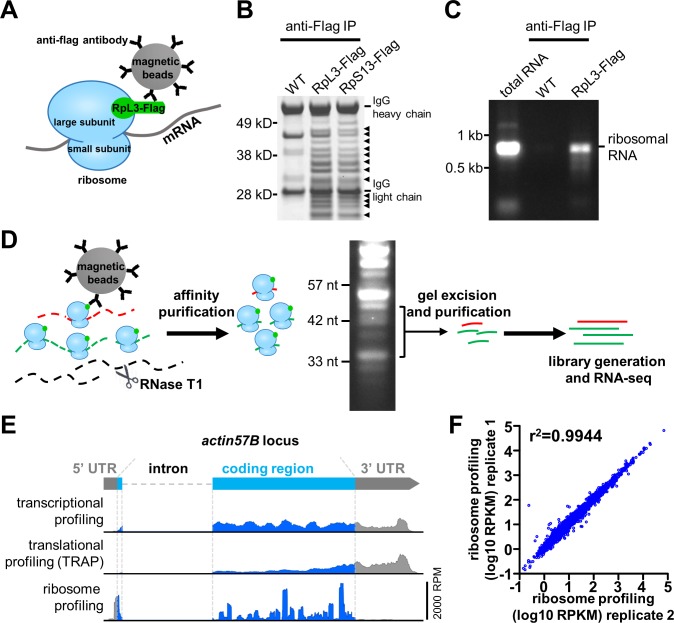
Development and validation of an optimized tissue specific ribosome profiling protocol in Drosophila.(A) Schematic illustrating the ribosome affinity purification strategy. A tagged ribosome subunit (RpL3-Flag) is expressed and incorporated into ribosomes. Magnetic beads coated with anti-flag antibodies are used to immunoprecipitate ribosomes along with associated mRNAs. (B) Anti-flag immunoprecipitation from wild type (control), postsynaptic expression of RpL3-Flag (w;BG57-Gal4/UAS-RpL3-3xflag), and postsynaptic expression of RpS13-Flag (w;BG57-Gal4/UAS-RpS13-3xflag) in third-instar larval muscle. Samples were run on an SDS-PAGE gel and Commassie stained. The expected distribution of ribosomal proteins are present in RpL3-Flag and RpS13-Flag samples (noted by arrowheads), but not observed in wild-type controls. (C) Total RNA was extracted from anti-flag immunoprecipitations from wild type and RpL3-Flag larval muscle tissue and run on an agarose gel. Ribosomal RNA is present in RpL3-Flag RNA samples but absent in wild type samples. Total RNA extracted from wild type whole larvae was loaded to show the position of ribosomal RNA. (D) Workflow for the ribosome profiling strategy. (E) Representative RNA-seq mapping of the actin57B locus from transcriptional, translational (TRAP), and ribosome profiling. Note that ribosome profiling reads predominantly map to 5’UTR and coding regions, and are absent from the 3’UTR. RPM: reads per million total mapped reads. (F) Replicate ribosome profiling sequencing demonstrates highly reproducible results.